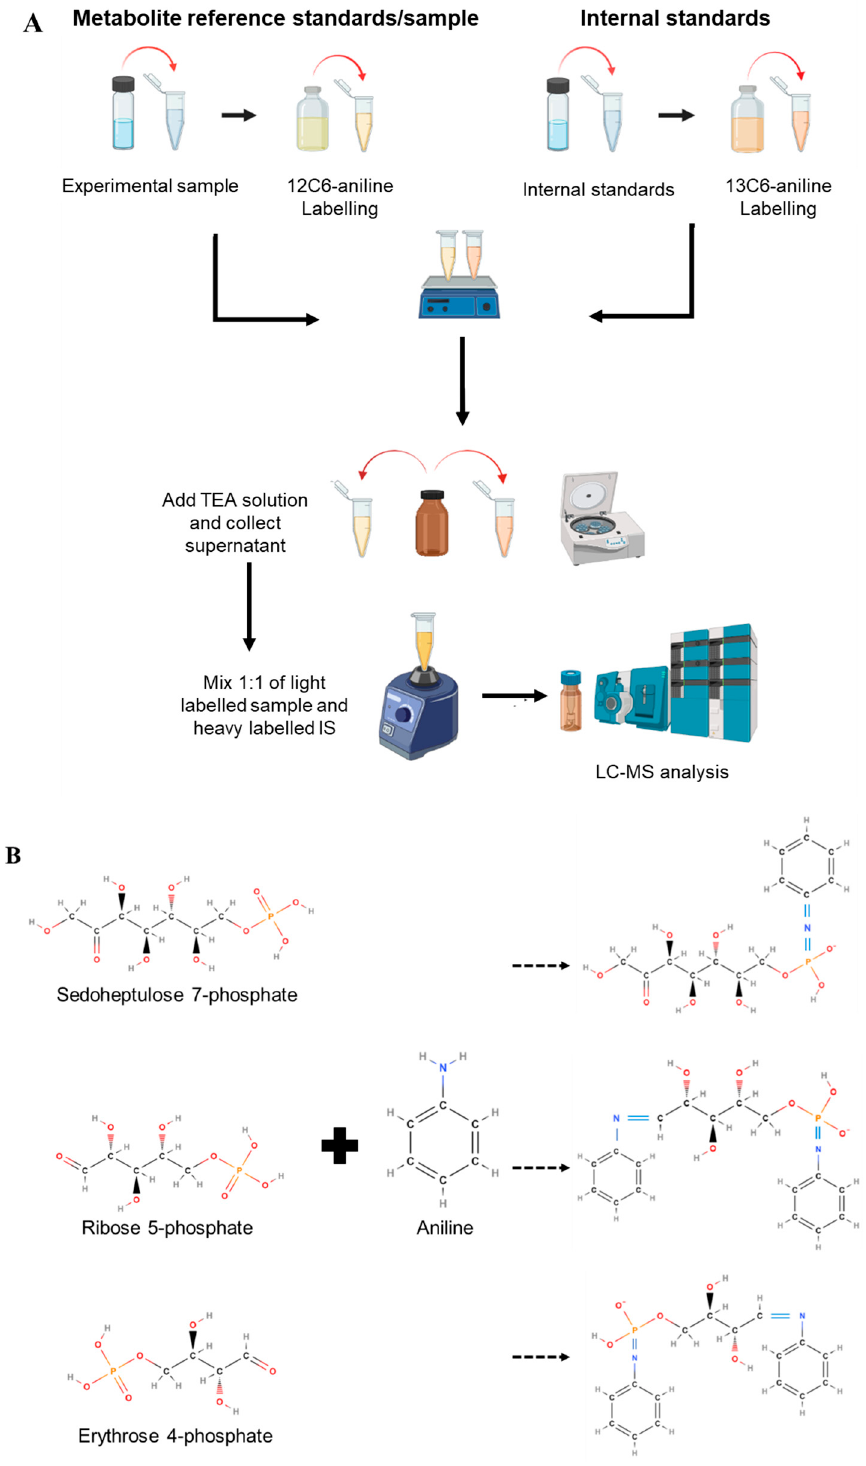
Figure 2. Strategy of aniline tagging method. ( A ) Preparation steps for stable isotope labeling of aniline for experimental samples and internal standards. ( B ) Tagging of PPP metabolites with aniline isotope. For R5P and E4P, one mole of aniline is attached to the phosphate and aldose groups, respectively. For S7P, only one mole of aniline is attached to the phosphate group.